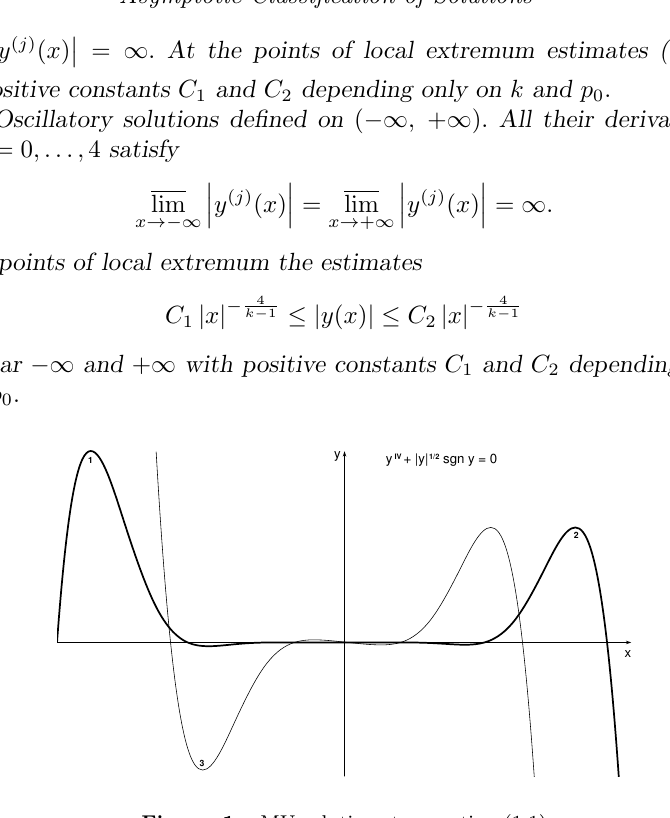
Figure 1. MU-solutions to equation